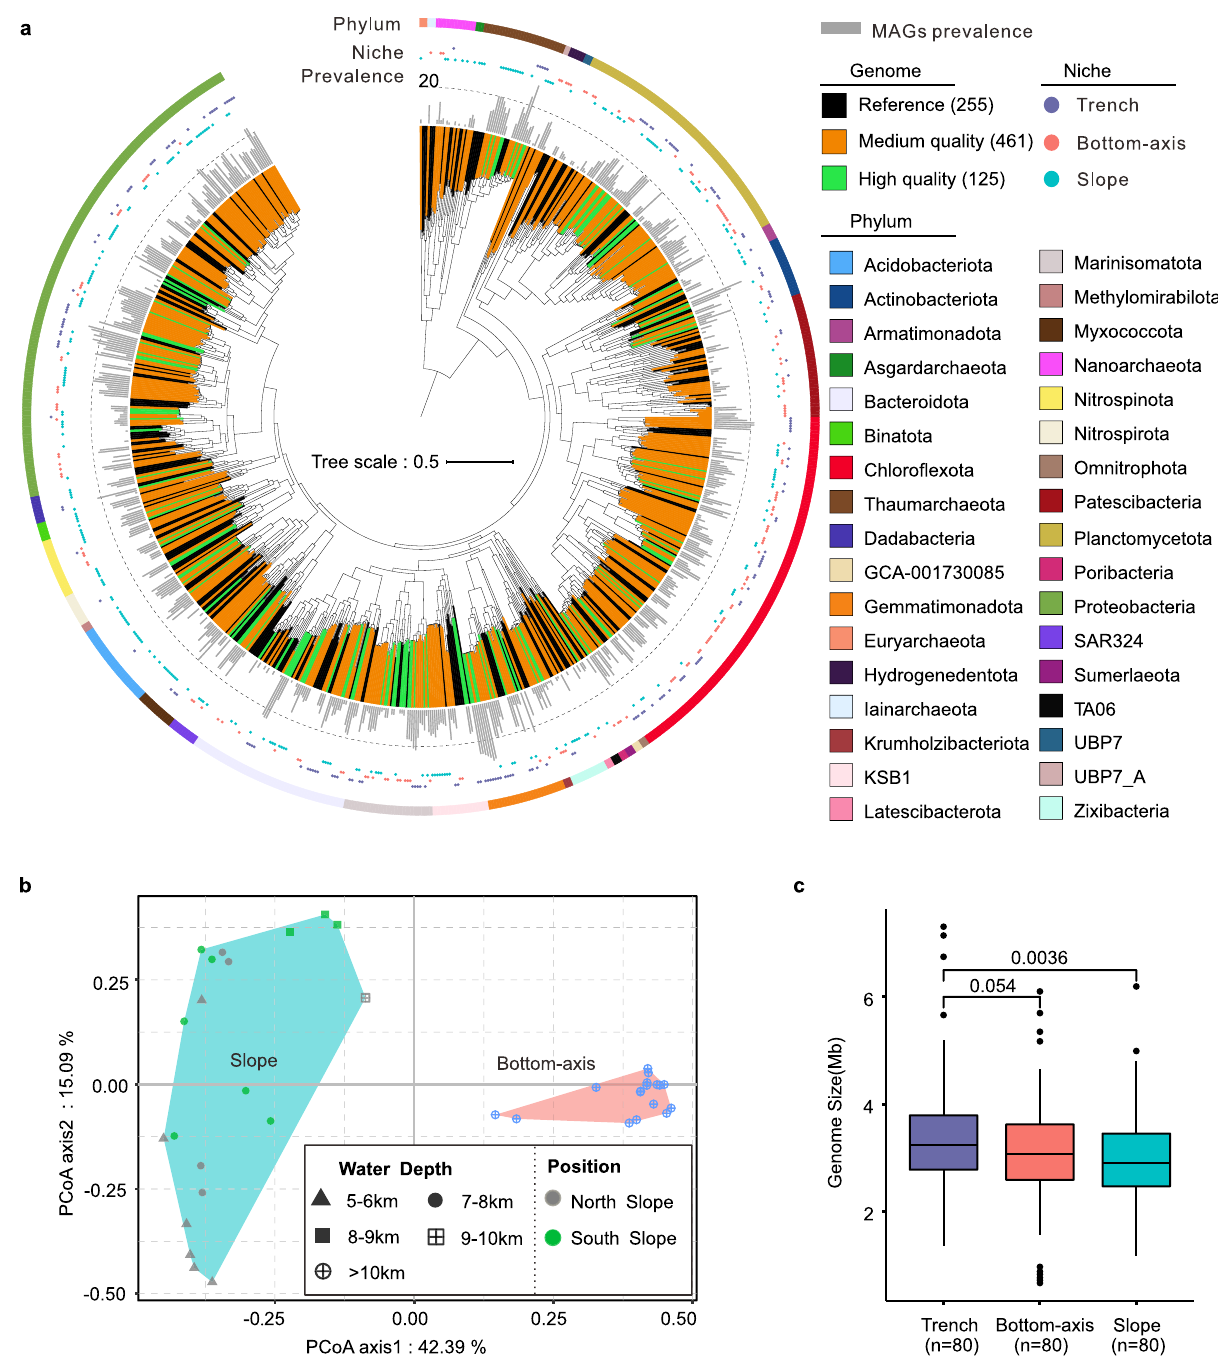
Fig. 2 Phylogeny, taxonomy, and genome size of reconstructed metagenome-assembled genomes (MAGs). a Maximum-likelihood phylogenomic tree of the 586 MAGs (green and orange clades present high and medium quality MAGs, respectively) and 255 reference genomes (black clades) from GTDB. The cyan dots present MAGs unique to slope sediments, the red shows MAGs unique to bottom-axis sediments, and the purple dots represent MAGs found in both slope and bottom-axis sediments (Trench). Gray bars show the prevalence of the MAGs in the 37 metagenomes. b PCoA ordination analysis using the relative abundance of MAGs and Bray-Curtis dissimilarity index. c Comparison of estimated genome size of the top 80 prevalent MAGs found in bottom-axis (Bottom), slope (Slope), and in both slope and bottom-axis sediments (Trench). p values were estimated with a two-sided t test analysis using the Trench MAGs as reference. In the box plot, center lines indicate median values. The lower and upper bounds represent 25th and 75th percentiles, respectively. The lower/upper whiskers represent minima/maxima no further than 1.5 times the interquartile range from the hinge, and the points falling outside of the whiskers represent the outliers. Source data are provided as a Source data fi